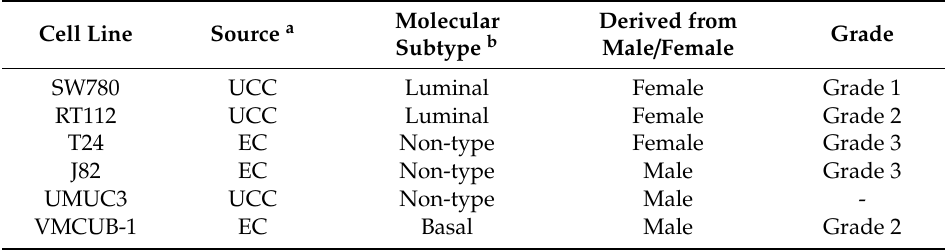
Table 1. General characterization and molecular subtypes of the bladder carcinoma cell lines.